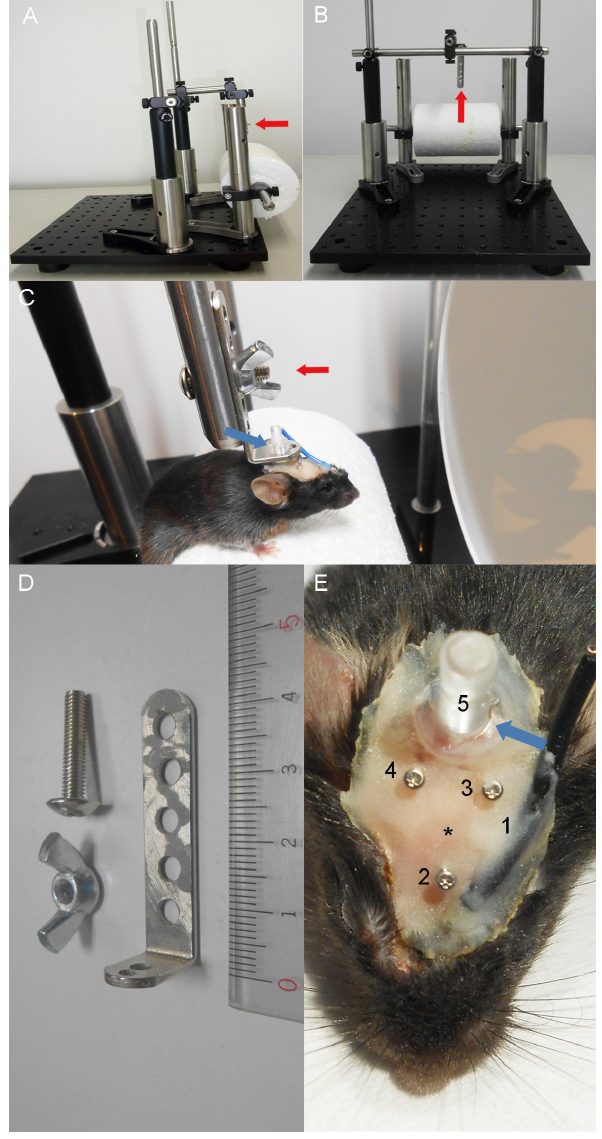
Fig 1. Setup for awake ERG/VEP recording. A, B, Images of the device used to fix the skull of a mouse while recording awake ERGs and VEPs. C, Experimental setup for recording. A mouse with head fixed to the restraint device was placed on a rotatable polystyrene cylinder. The setup allows the mouse to run or walk freely during ERG/VEP recording. Electrical cords, which are not shown in the image, were connected to the electrodes on the skull during recording. D, An adaptor, a nut, and a bolt used to connect a mouse to the vertical attachment of the restraint device (red arrows in panels A, B, and C). The ends of the adaptor linked the mouse skull to the restraint device and platform. E, Screw electrode, fixation bolt, and wire electrode implants: 1, reference wire electrode for ERG; 2, reference screw electrode for VEP; 3, 4, positive screw electrodes for VEP; 5, plastic bolt used to attach the skull to the fixation device (see blue arrows in panels C and E); asterisk,